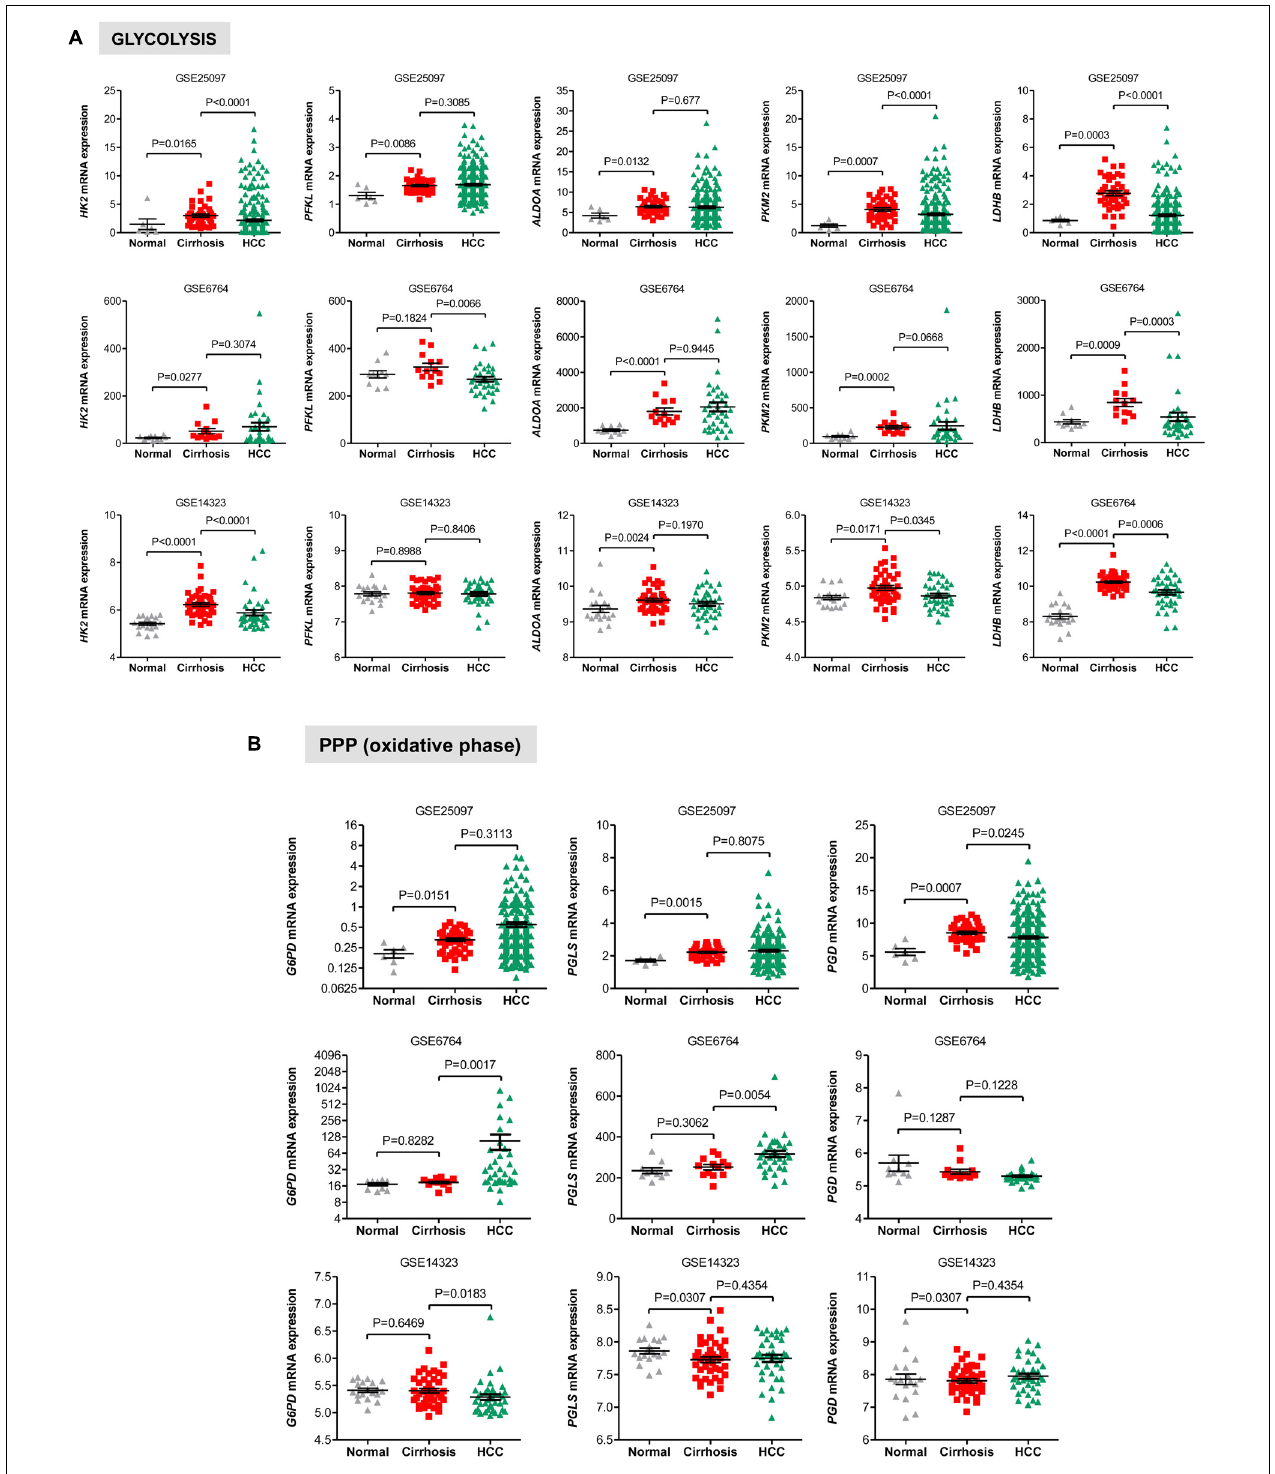
FIGURE 5 | Gene expression of glycolysis and PPP enzymes in cirrhotic and HCC livers. (A) Scatterplots showing the increased expression of transcript levels of representative glycolytic enzymes in cirrhotic livers compared to HCC livers and normal healthy liver tissues in three independent clinical data sets GSE25097, GSE6764, and GSE14323 (Wurmbach et al., 2007; Sung et al., 2012; Levy et al., 2016). (B) Scatterplots showing differential gene expression of genes related to oxidative PPP among cirrhotic livers compared to HCC livers and normal healthy liver tissues in three independent clinical data sets GSE25097, GSE6764, and GSE14323 (Wurmbach et al., 2007; Sung et al., 2012; Levy et al., 2016). The horizontal lines indicate mean ± SEM P -values were calculated by non-parametric Mann–Whitney tests.